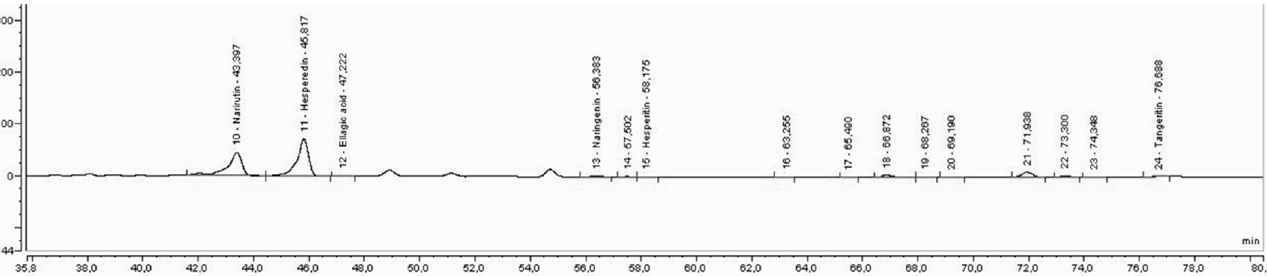
Figure 4. Chromatogram of the extraction performed with DES3 by one step.